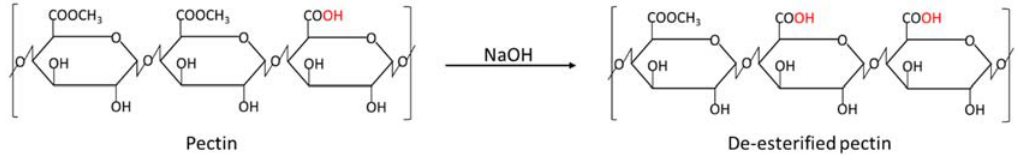
Figure 1. The de-esterification reaction of pectin using Figure 1. The de ‐ esterification reaction of pectin using NaOH.